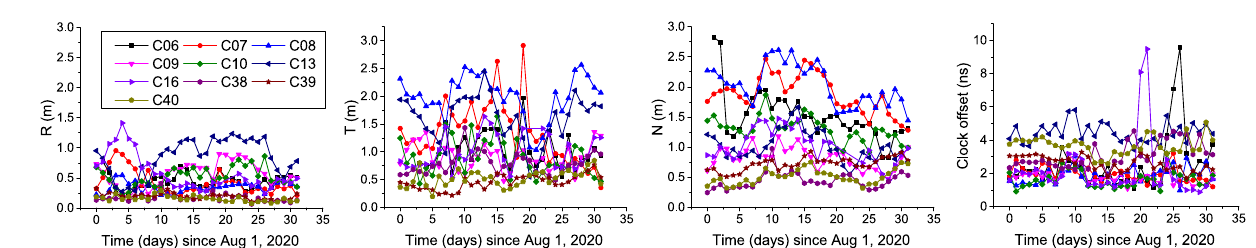
Figure 2. Orbit and clock offset accuracy variations of the GEO satellites. From left to right: Radial, tangential, normal, satellite clock offset.